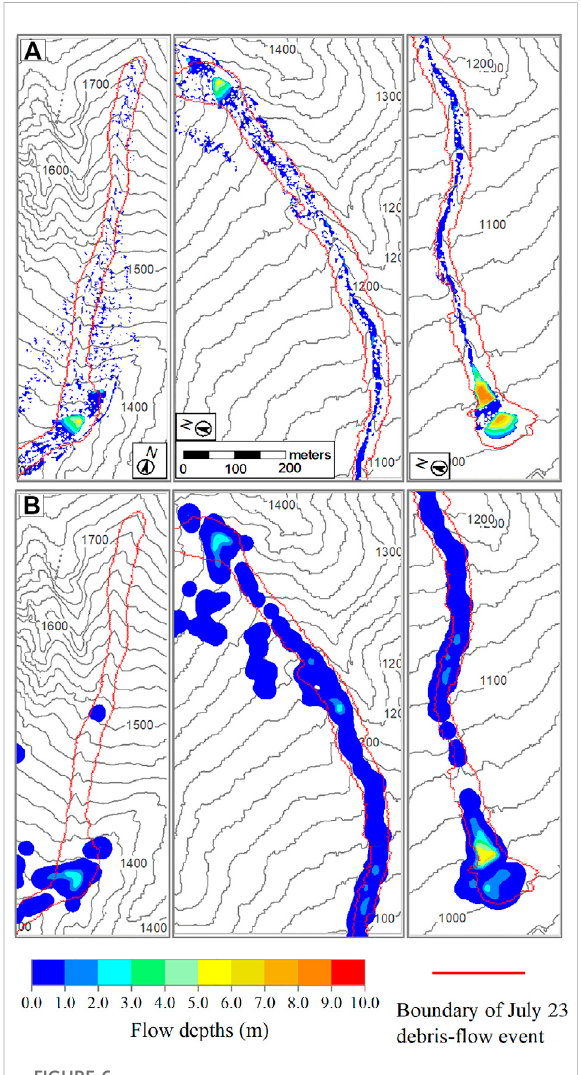
FIGURE 6 Comparison between (A) Shen ’ s model and (B) DAN3D code in terms of fl ow depth at end of numerical simulation (The fl ow depthscontours areat1-mintervals;Theelevation contoursareat 20-m intervals).